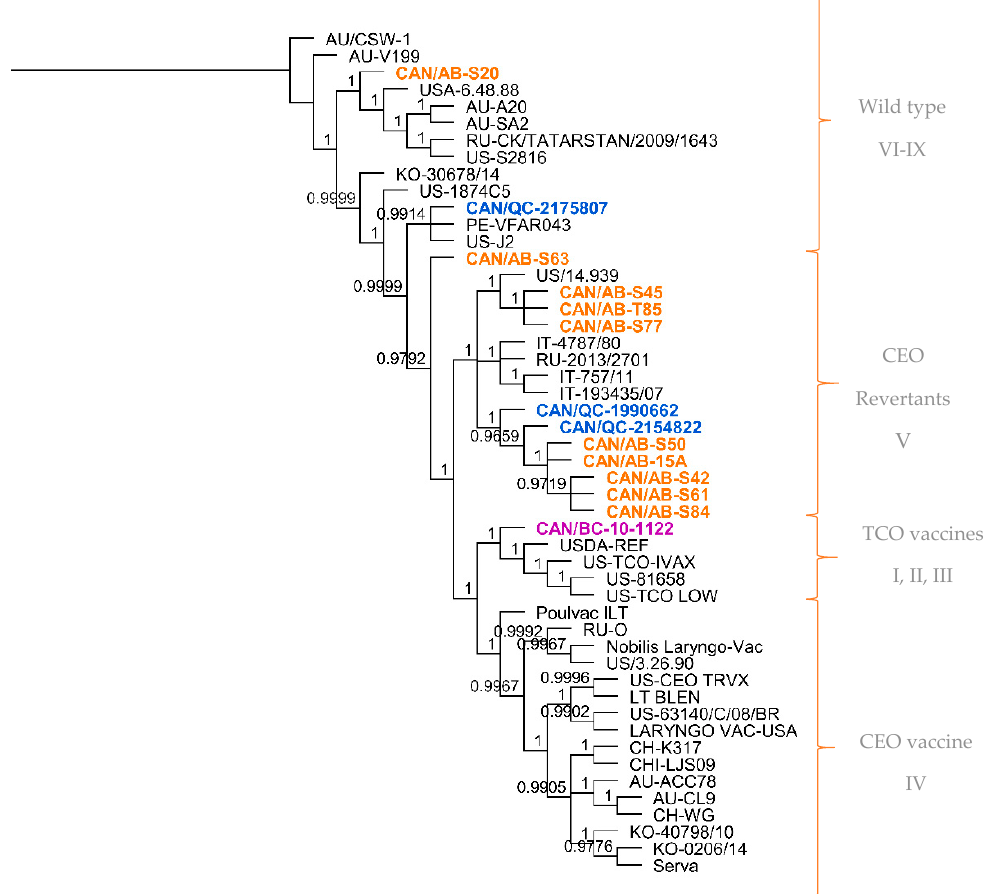
Figure 1. Phylogenetic tree of the full genome sequences of 50 ILTV strains from different geographical regions. Tree was generated using the Bayesian inference method (MrBayes, Geneious software). Posterior probability values are indicated as branch labels in the tree. Sequences highlighted in orange represent the Alberta ILTV isolates; in blue, the Quebec ILTV isolates and in purple is the ILTV isolate originated in British Columbia. Brackets and labels to the right of the tree separate and indicate the suggested genotype according to the clustering of the sequences in the phylogenetic tree.